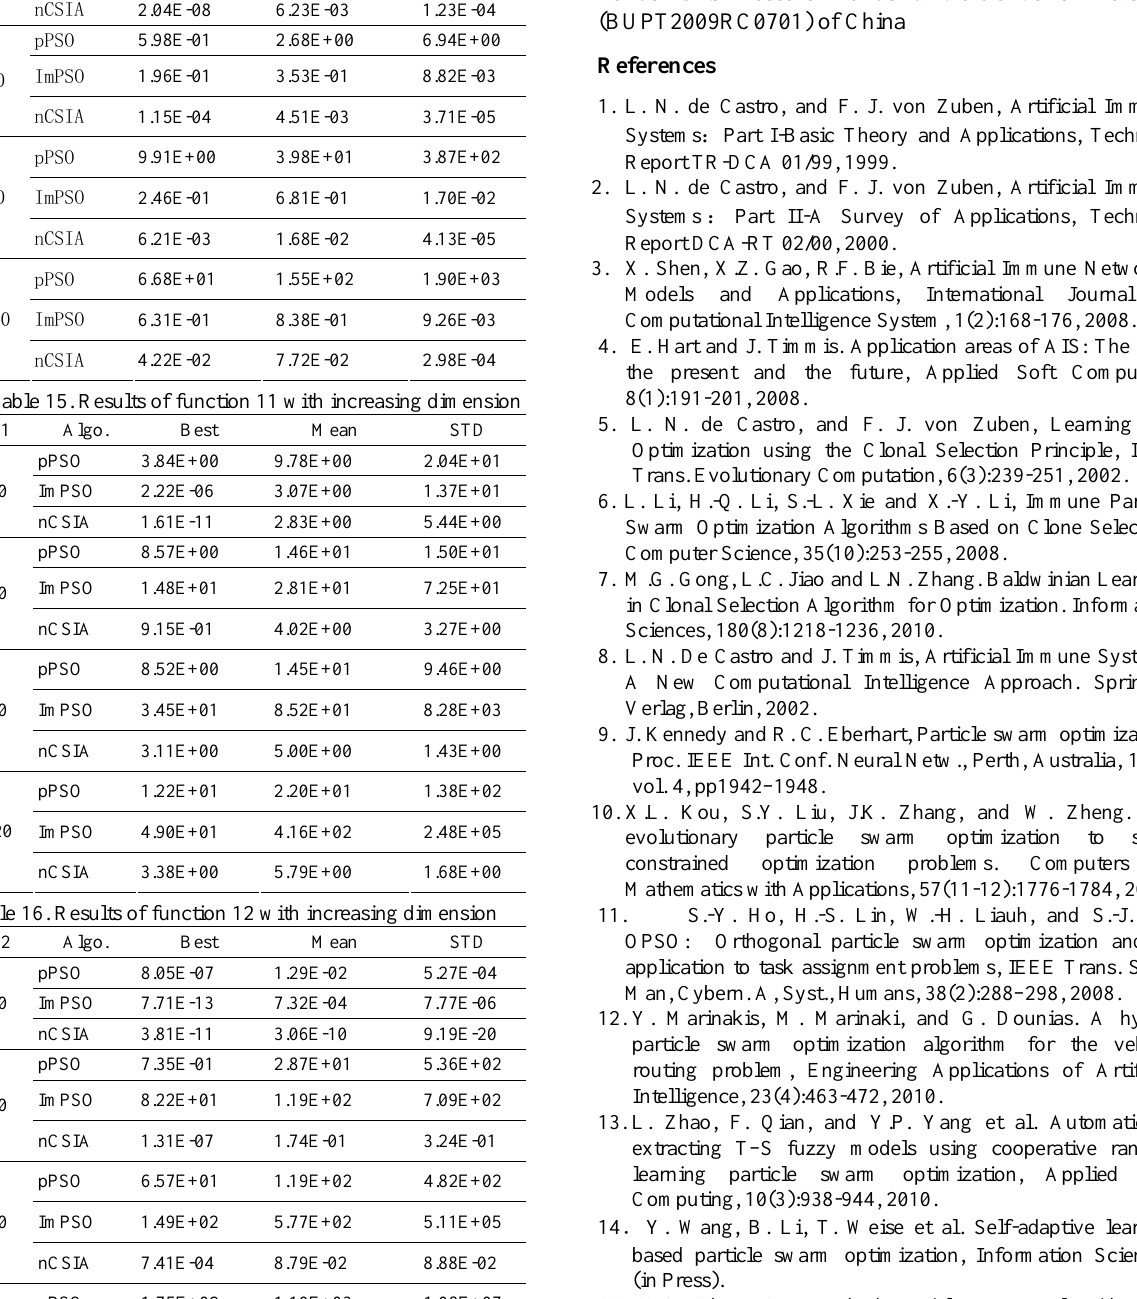
Table 16. Results of function 12 with increasing dimension f12